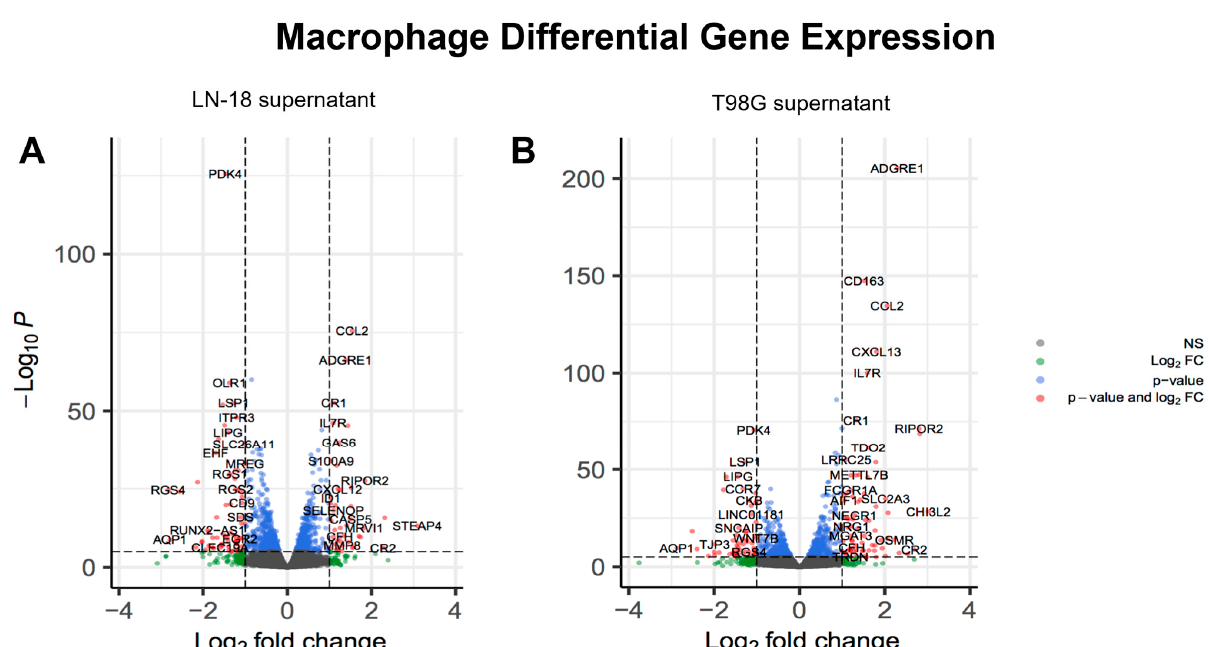
Figure 4. Volcano plot of differentially expressed genes in ( A ) macrophage treated with LN-18 control supernatant compared to untreated macrophage and ( B ) macrophage treated with T98G control supernatant compared to untreated macrophage. All genes shown as dots. Significantly differentially expressed genes ( p < 0.05) are colored above the horizontal line as blue or red. Genes with DGE > |1| are shown in red left and right of the vertical lines and are all labeled.